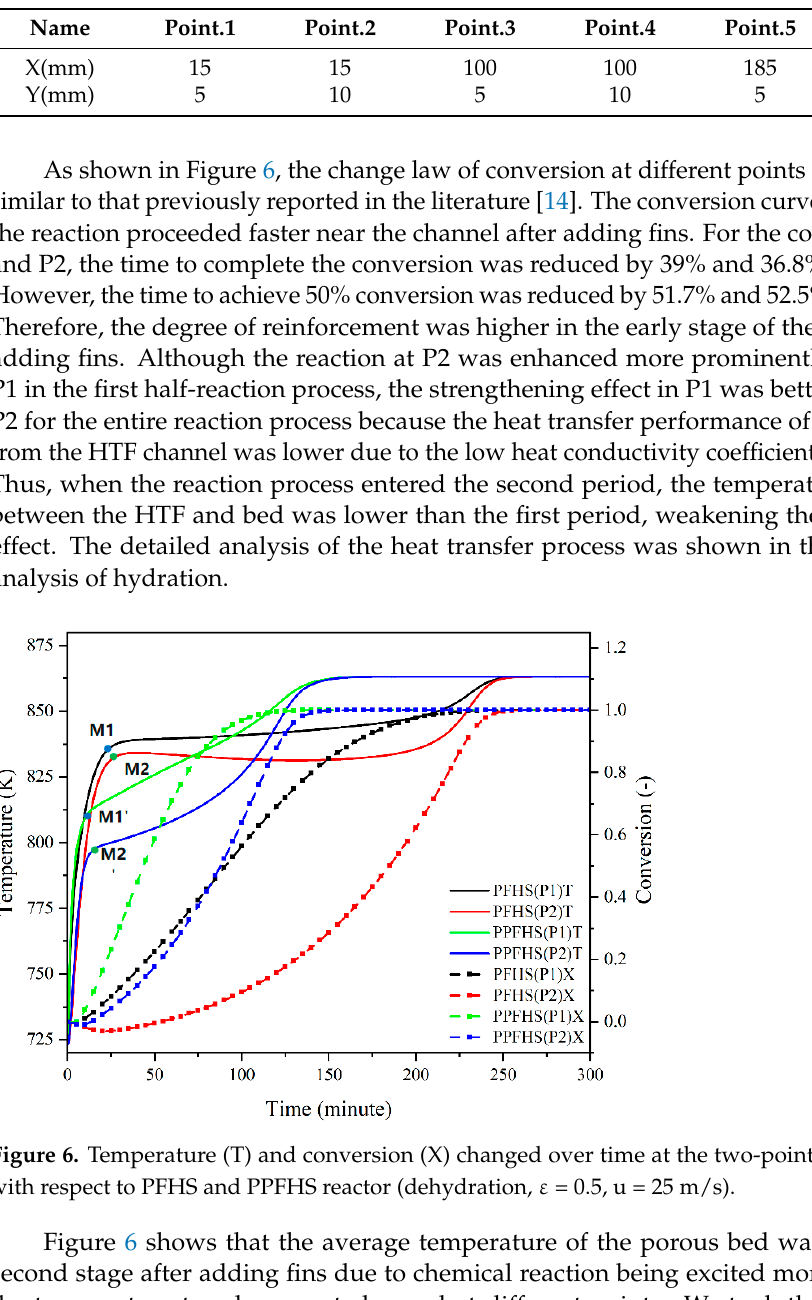
Figure 7. Heat flux (Q) of thin shells and pressure (P) at the inlet of the flow channel over time of three kinds of reactors (dehydration, ε = 0.5, u = 25 m/s). Figure 8. Streamline profile in the channel at 300 min (dehydration, ε = 0.5, u = 25 m/s). ( a ) PPFHS reactor. ( b ) HPPFHS reactor. ( c ) PFHS reactor.